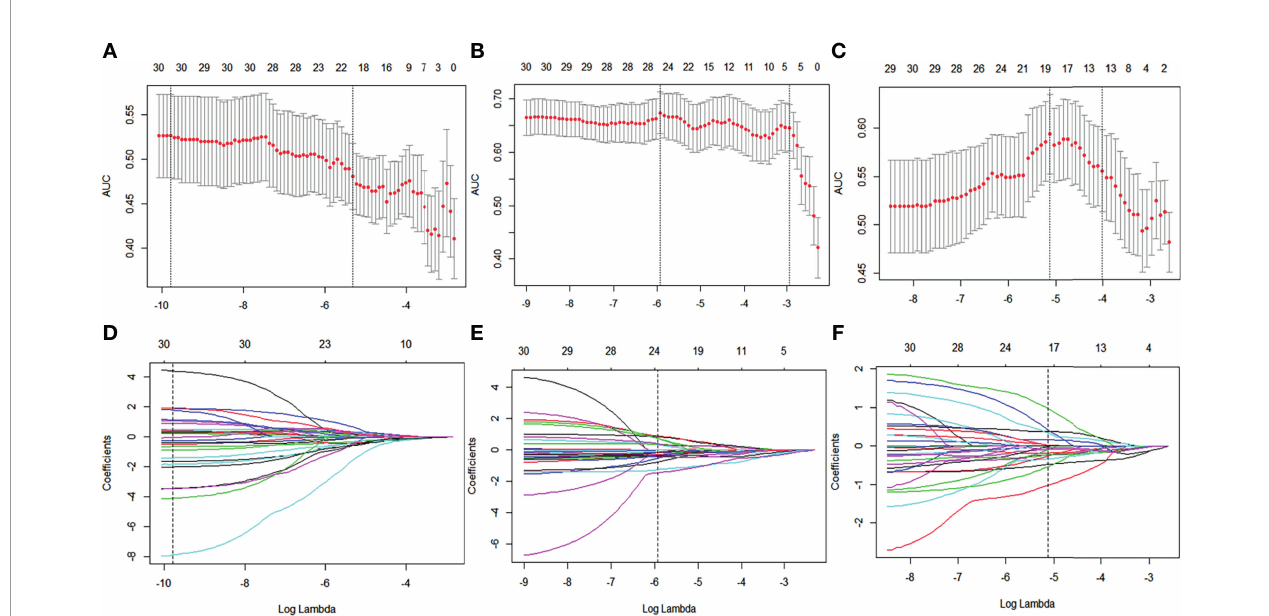
FIGURE 3 | Baseline, early treatment, and delta radiomics feature selection by LASSO regression. (A – C) Selection of tuning parameters (lambda value) in the LASSO model using 10-fold cross-validation by the minimum criteria. (D – F) LASSO coef fi cient pro fi les of the radiomics features.